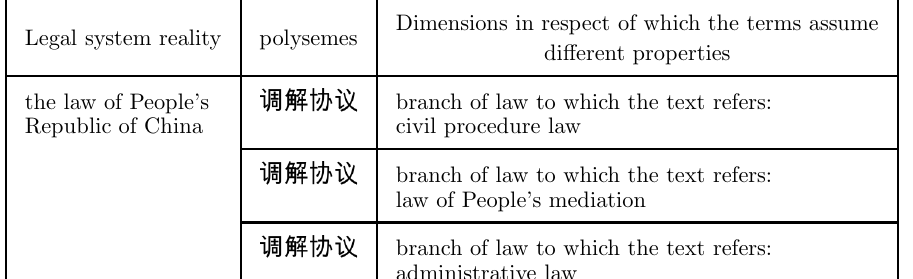
The semantic relation of polysemy at the intralingual